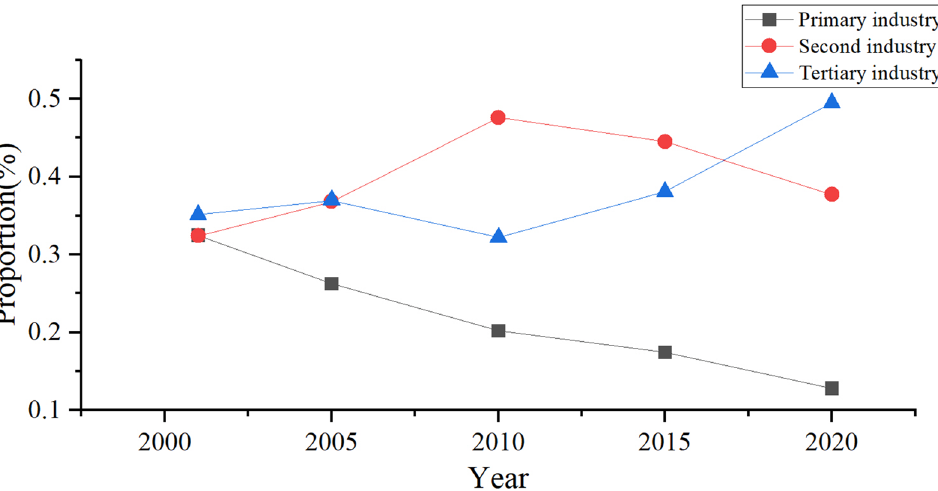
Figure 8. The proportion of the primary industry, secondary industry, and tertiary industry in regional GDP from 2001 to